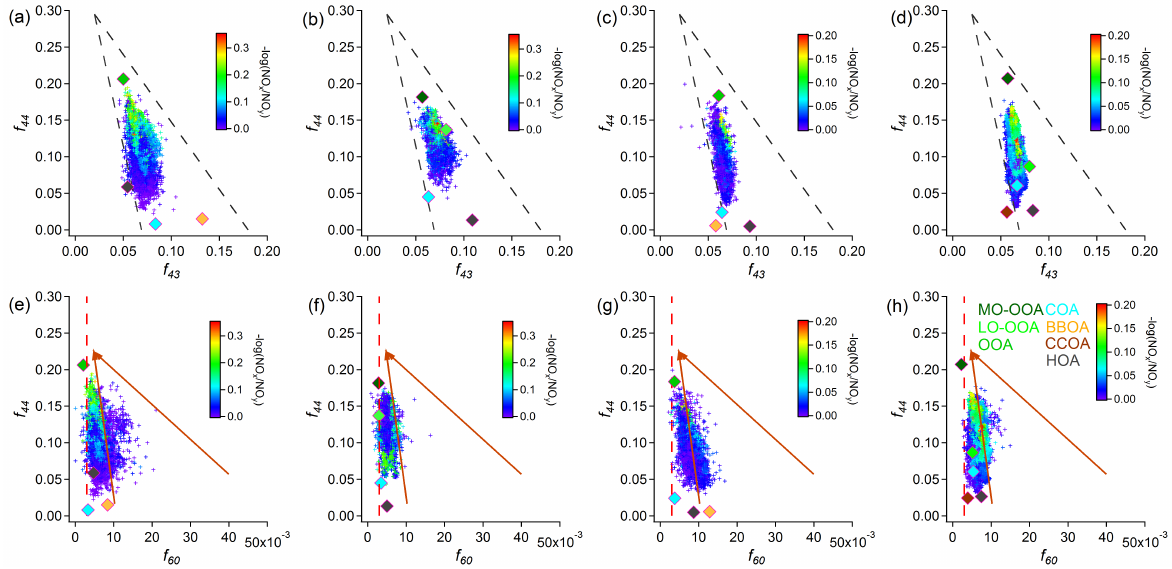
Figure 10. Scatterplots of f 44 vs. f 43 and f 44 vs. f 60 in OA during the spring (a, e) , summer (b, f) , autumn (c, g) , and winter (d, h) observations. The triangle for f 44 against f 43 derived by Ng et al. (2010) is lineated. The conceptual space for BBOA and the nominal background value at 0.3% (Cubison et al., 2011) are marked by arrows and vertical dash lines, respectively. The scatterplots are colored by the metric − log(NO x / NO y ) . The OA factors resolved by the AMS-PMF analysis are also marked in all